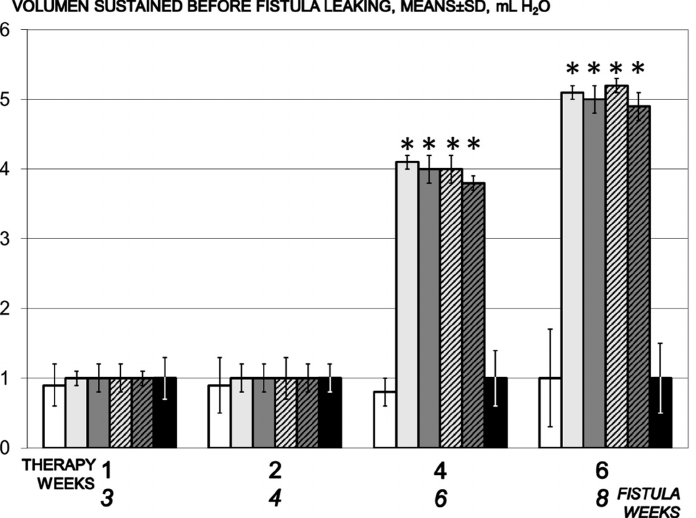
Figure 1. Volume that could be sustained before fistula leakage, mL H2O, means ± SD, time line. Therapy regimens starting at the day 14 after fistula creation (therapy day 0), included BPC 157 given once daily intraperitoneally, last application at 24 h before sacrifice, 10 µg/kg (light gray bars) or 10 ng/kg (dark gray bars) or given perorally, in drinking water 10 µg/kg/day (dashed light gray bars) or 10 ng/kg (dashed dark gray bars) until the sacrifice. Controls received simultaneously an equal volume of saline (5 mL/kg) intraperitoneally (white bars) or drinking water (12 mL/rat/day) (black bars). * p < 0.05, relative to control.